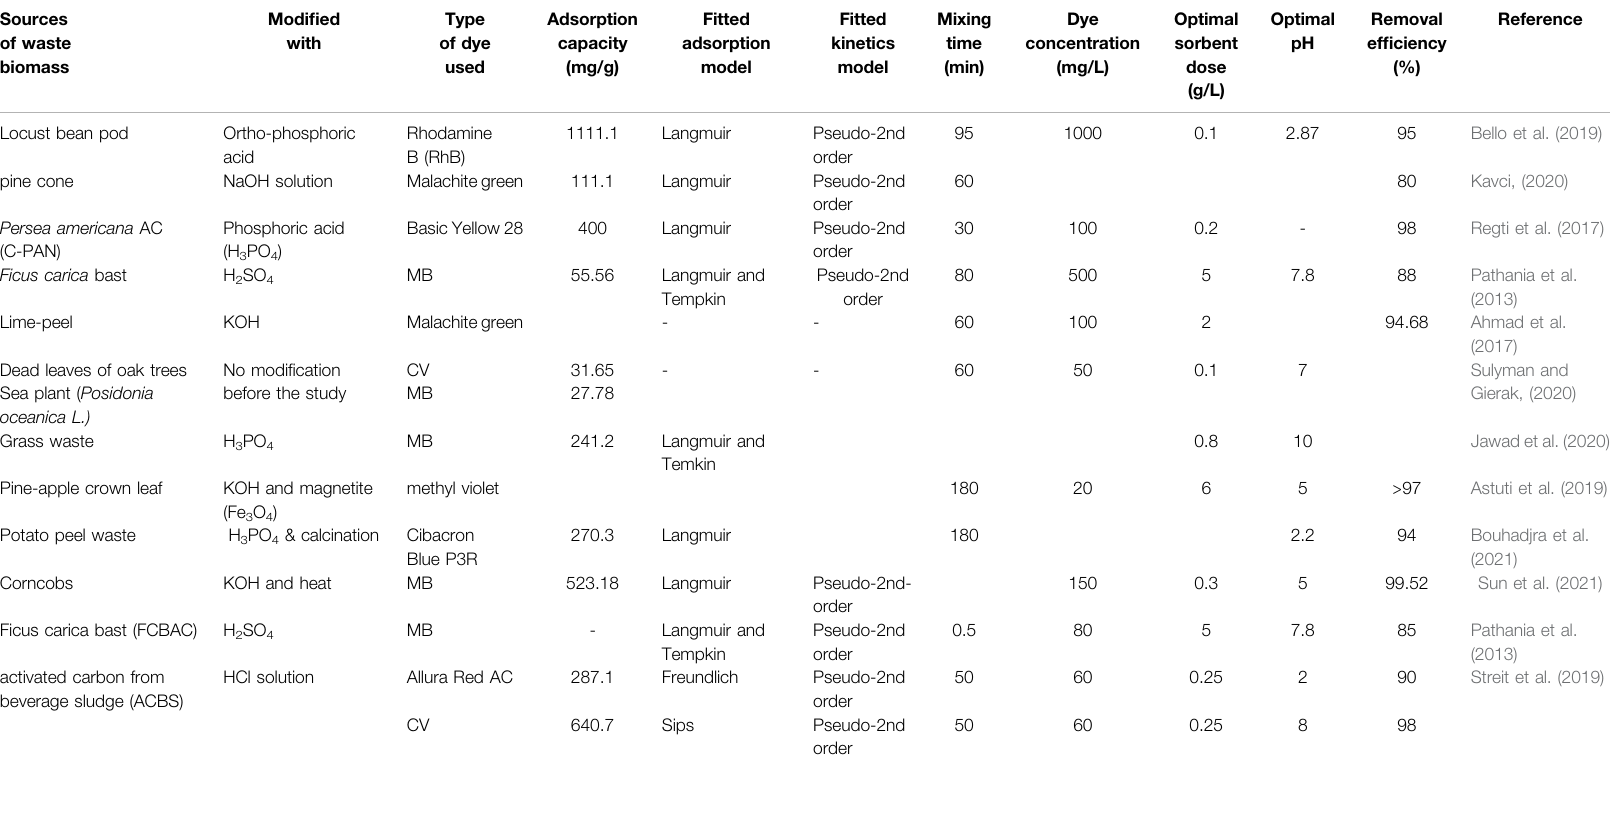
TABLE 7 | Applications of agricultural debris wastes for adsorptive removal of dyes. Sources of waste